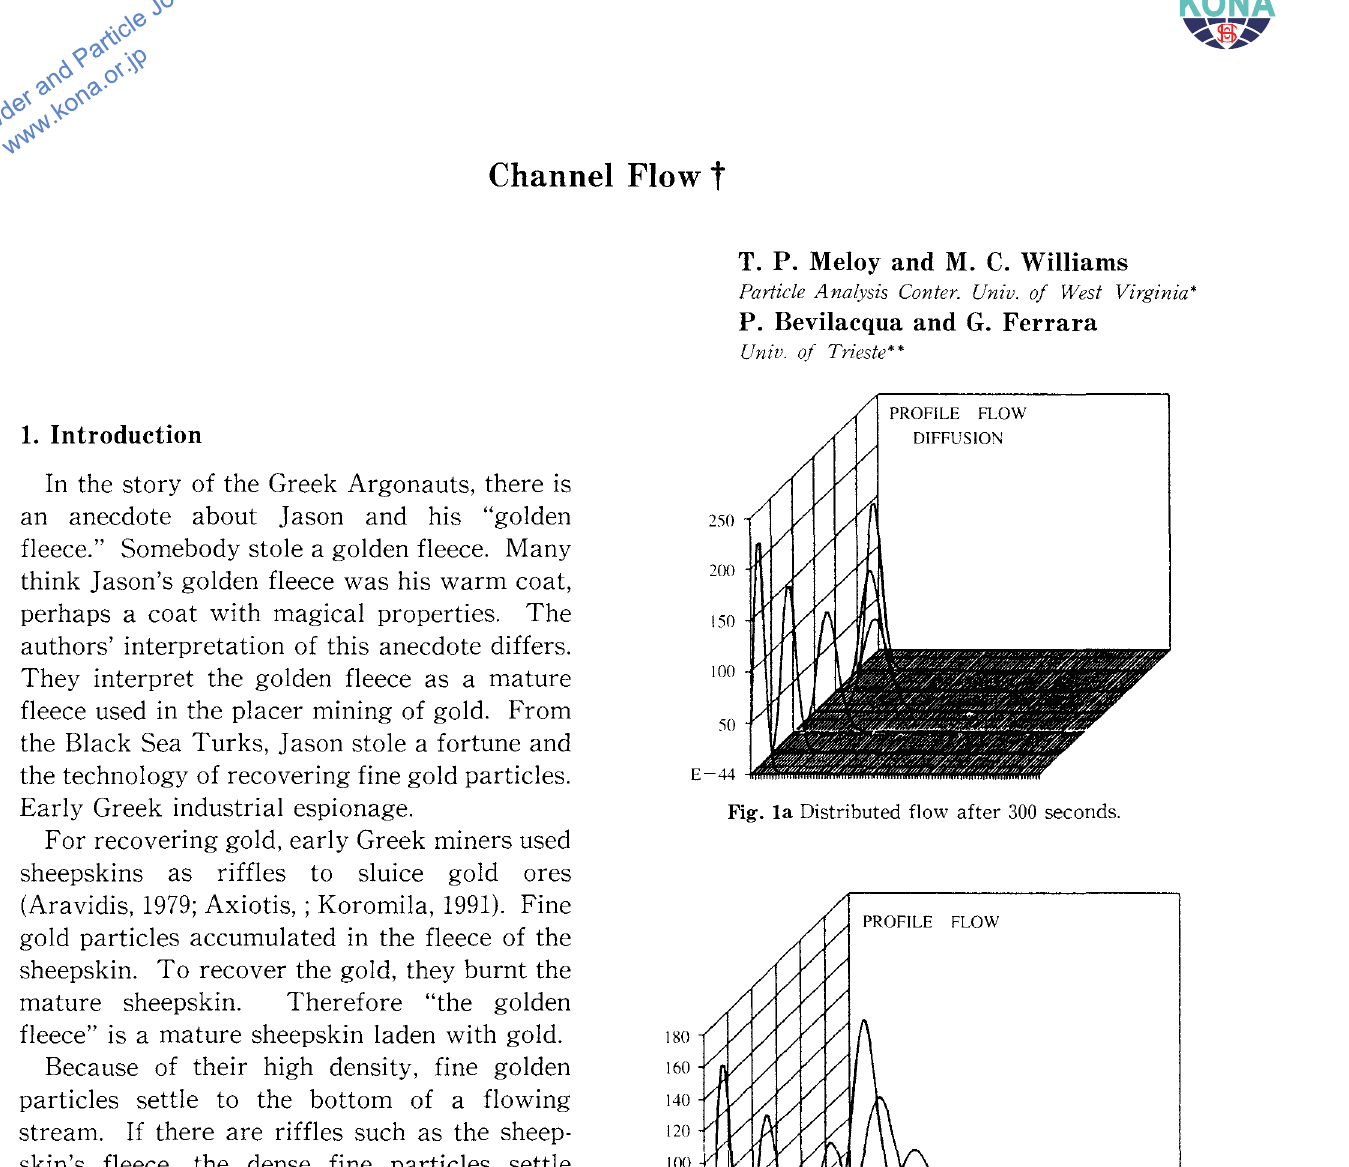
Fig. lb Distributed flow after 600